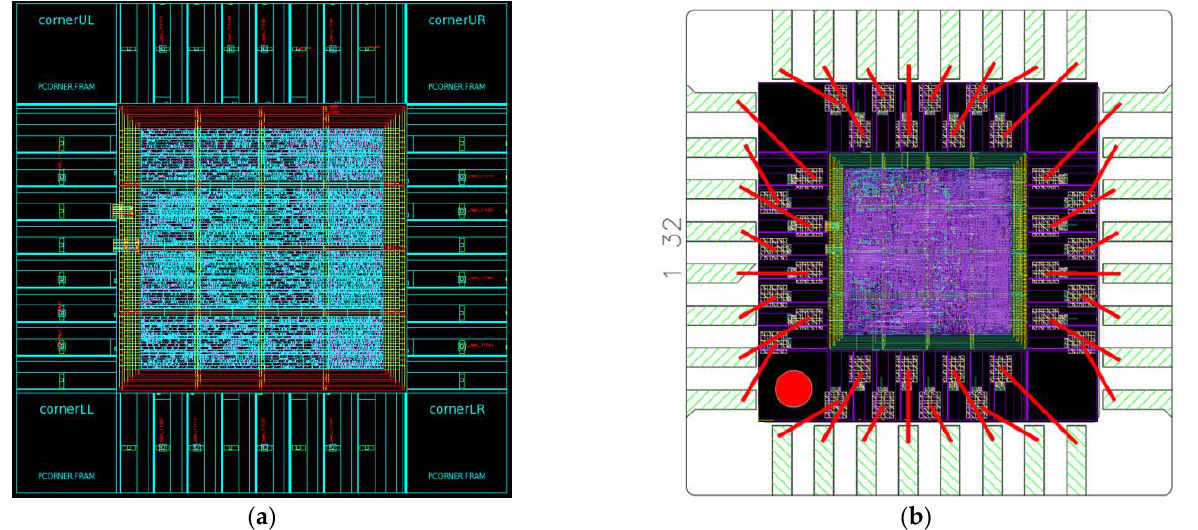
Figure 14. ( a ) Layout plan with IC Compiler. ( b ) Wire bonding photo.